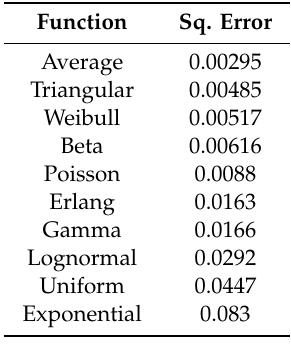
Table 3. Error table for daily arrival goodness-of-fit tests.